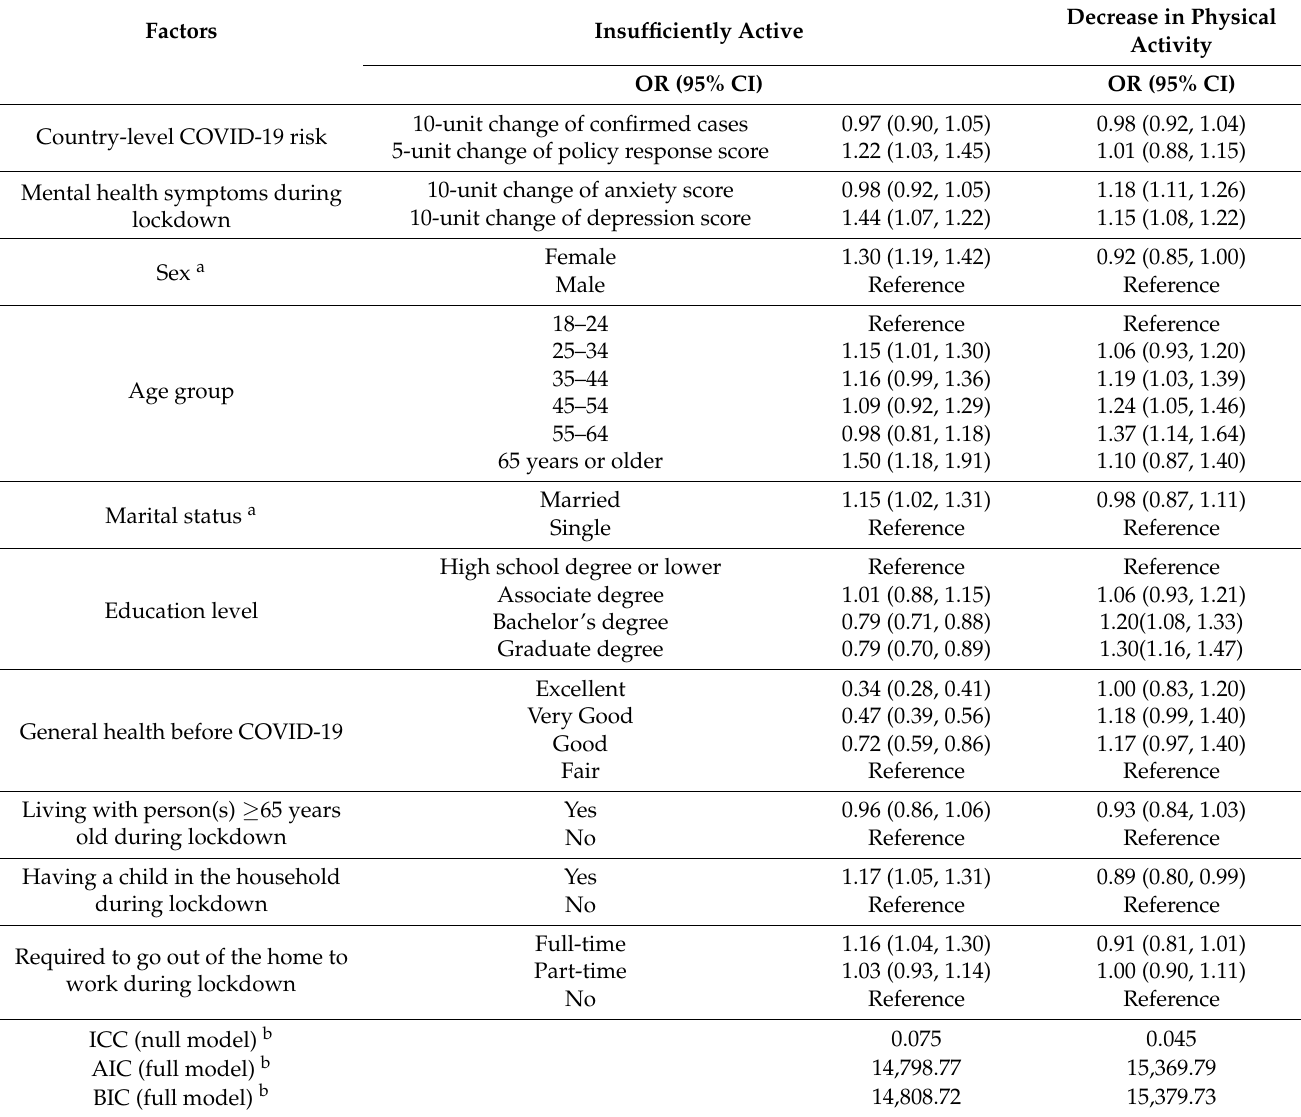
Table 3. Factors associated with physical activity during